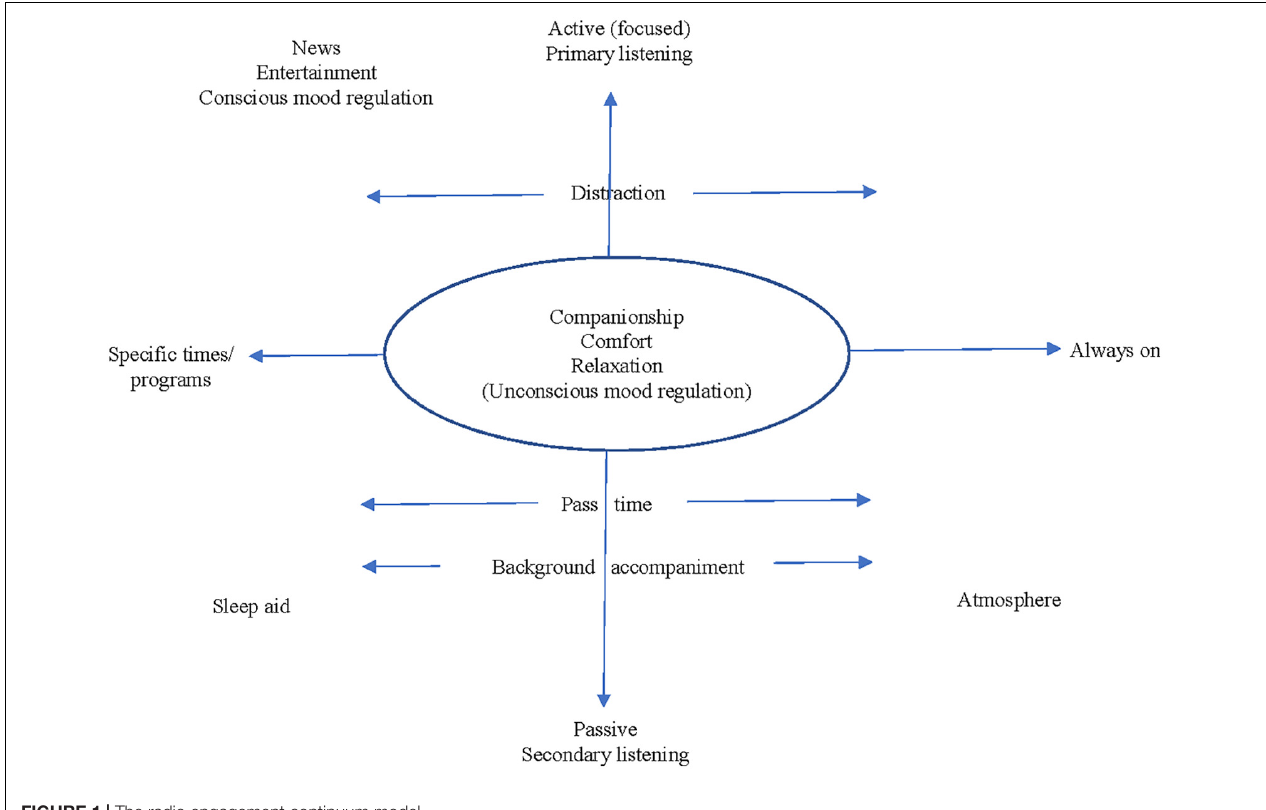
FIGURE 1 | The radio engagement continuum